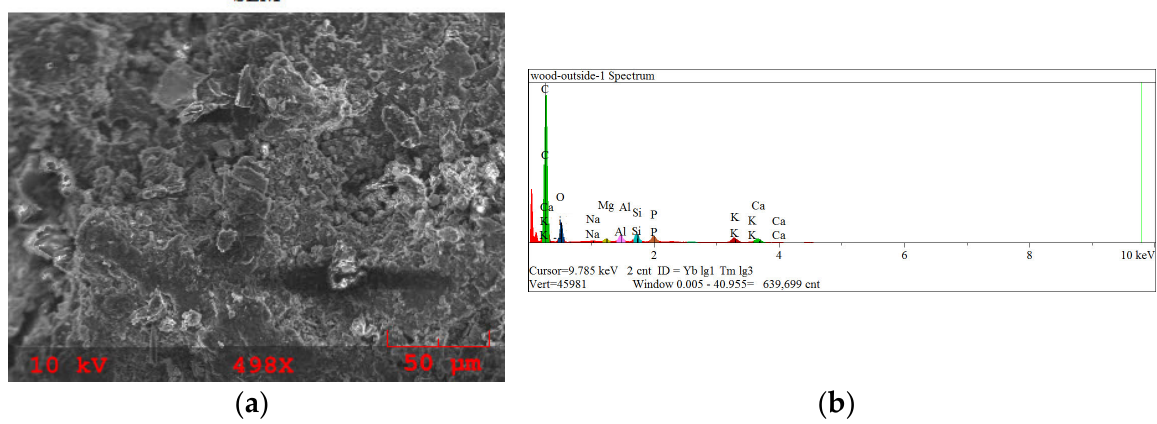
Figure 14. SEM of ( a ) outer wood biochar analysis ( b ) mineral concentration on outer wood–bottom (mineral from left to right K, Ca, O, Na, Al, Si, P, K, Ca).